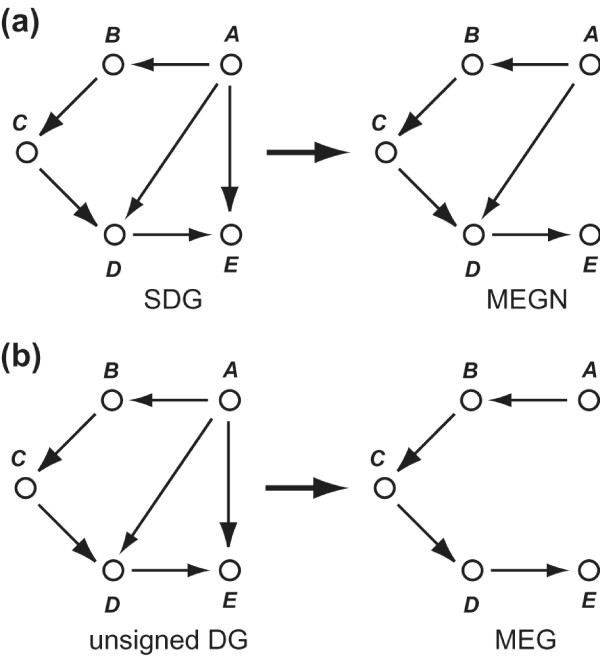
Difference between MEGN and MEG. Deduction of the MEGN (a) and the MEG (b) from the same graph is shown. The MEGN includes the edge from A to D because no two edges explain the edge. In contrast, the MEG does not include the edge from A to D because A can reach D without using the edge from A to D (A→B→C→D). The MEGN consists only of the essential edges.